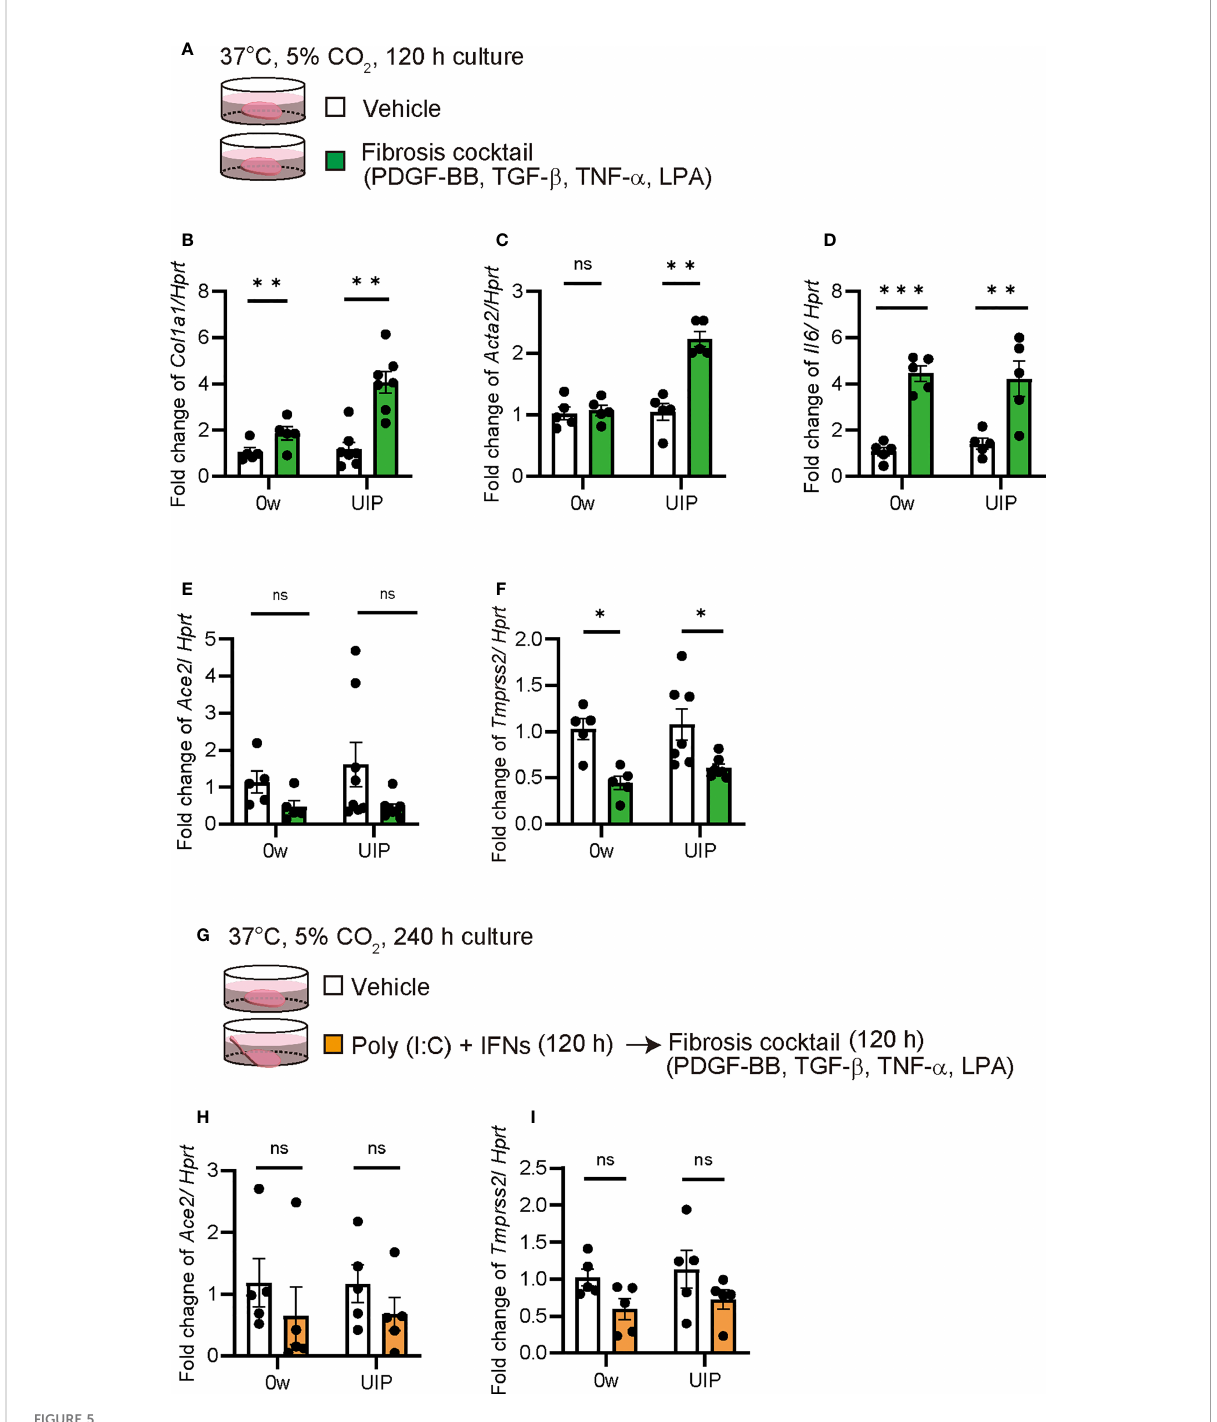
FIGURE 5 Fibrosis cocktail decreased Ace2 and Tmprss2 expression qPCRs using ex vivo culture of PCLS treated with fi brosis cocktail were performed. (A) Schematic diagram of the protocol for using a fi brosis cocktail in PCLS. (B – F) Fold changes in the expression levels of each gene, Col1a1 (B) , Acta2 (C) , Il6 (D) , Ace2 (E) , and Tmprss2 (F) at week 0 and the UIP stage. (G) Schematic diagram of the protocol using a fi brosis cocktail following the combination of poly(I:C) and IFNs in PCLS. (H, I) Fold changes in the expression levels of Ace2 (H) and Tmprss2 (I) . Hprt expression was used as an internal control for qPCR. Each bar represents the vehicle (white bars) or fi brosis cocktail (green or orange bars). Each mRNA was prepared from PCLS samples from each stage of the iUIP mouse model. Data are presented as mean ± SE of fi ve or seven mice. Asterisks indicate * P < 0.05, ** P < 0.01, *** P < 0.001, compared with week 0. “ ns ” is not statistically signi fi